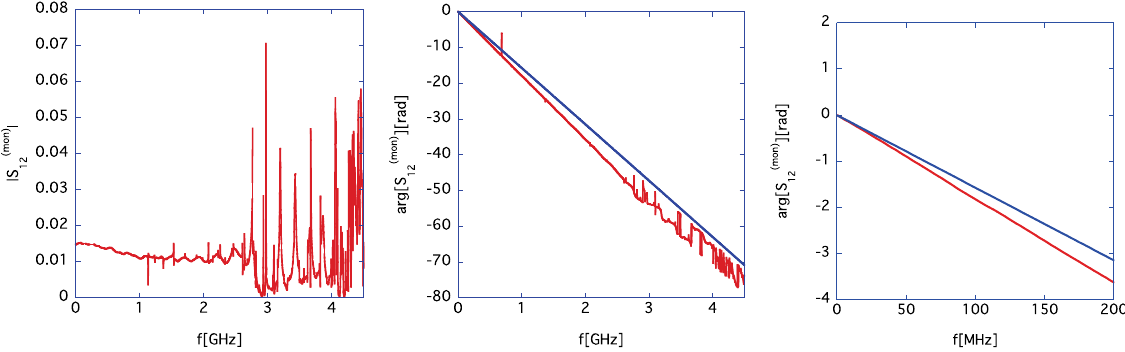
ð mon Þ 12 for the ceramic break in the upper figure of Fig. 4, where the right figure is a